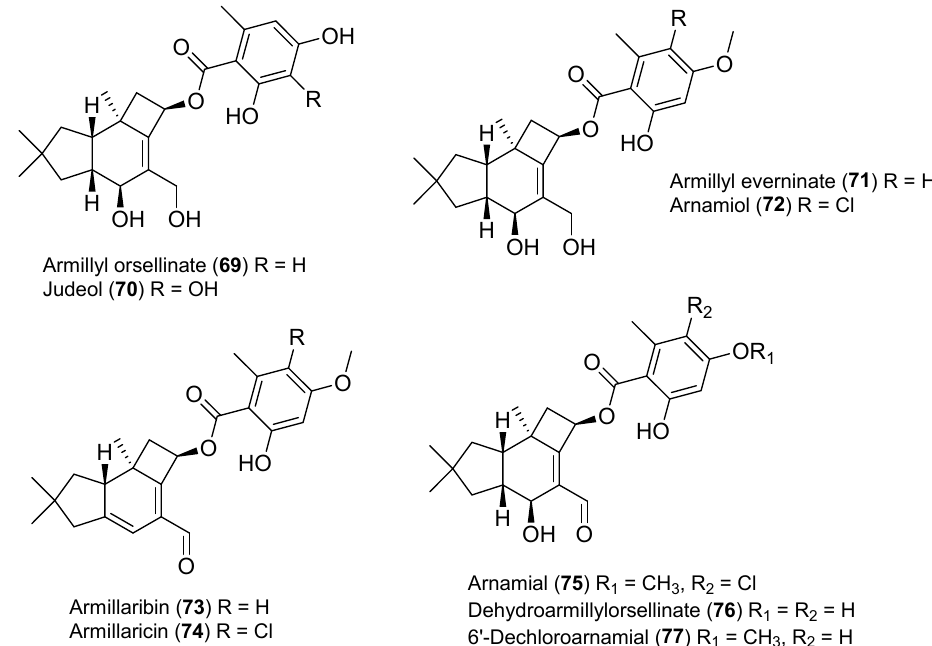
Figure 14. Structures of Δ 2,4 -protoilludene-containing aryl sesquiterpenoids 69 – 77 isolated from Armillaria mellea.